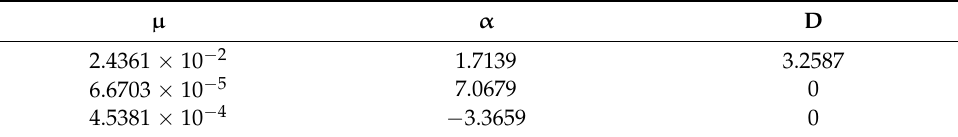
Table 3. The third-order Ogden model coefficients of